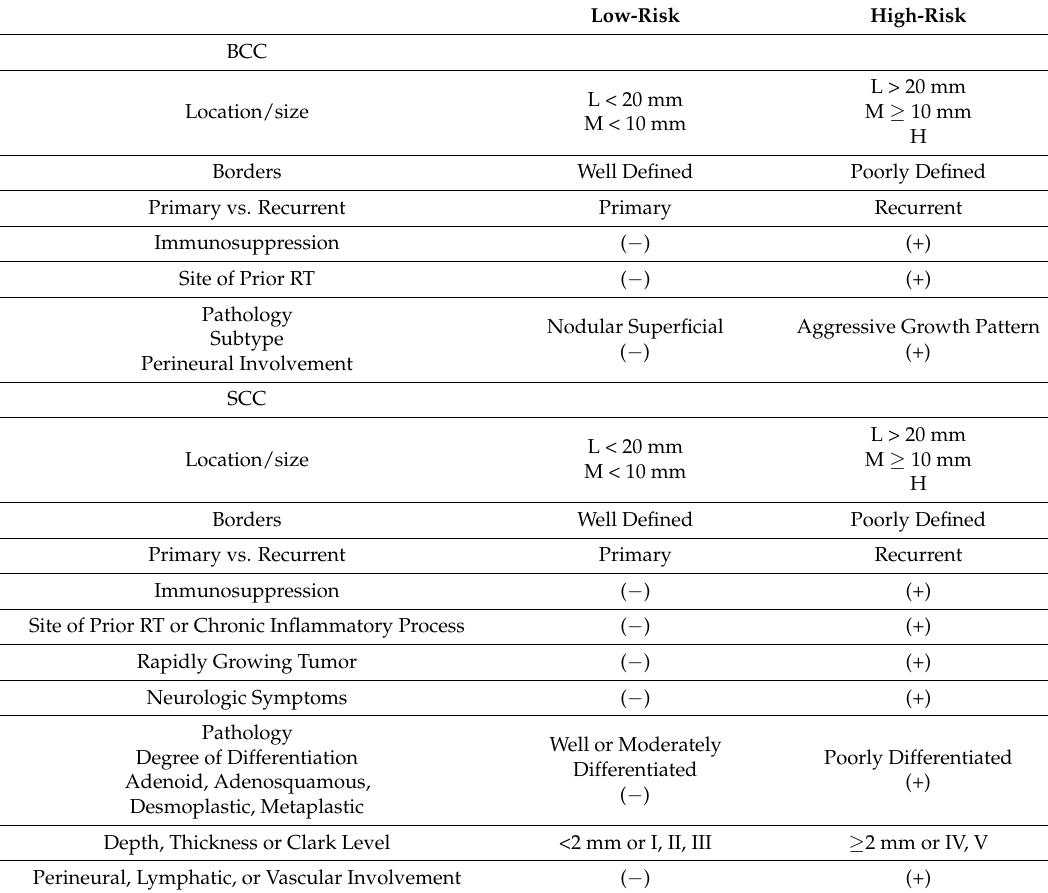
Table 5. National Comprehensive Cancer Network (NCCN) 2017 Guidelines for Risk Factors for Recurrence for basal cell carcinoma (BCC) and Recurrence and Metastasis for squamous cell carcinomas (SCC)